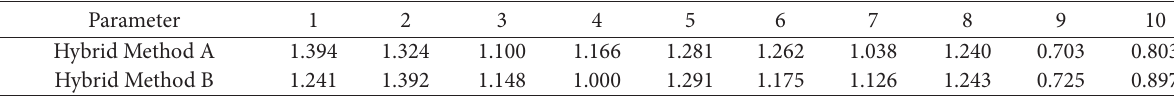
Table 2. Parameter values of modified model of bridge with two proposed methods Parameter 1 Hybrid Method A